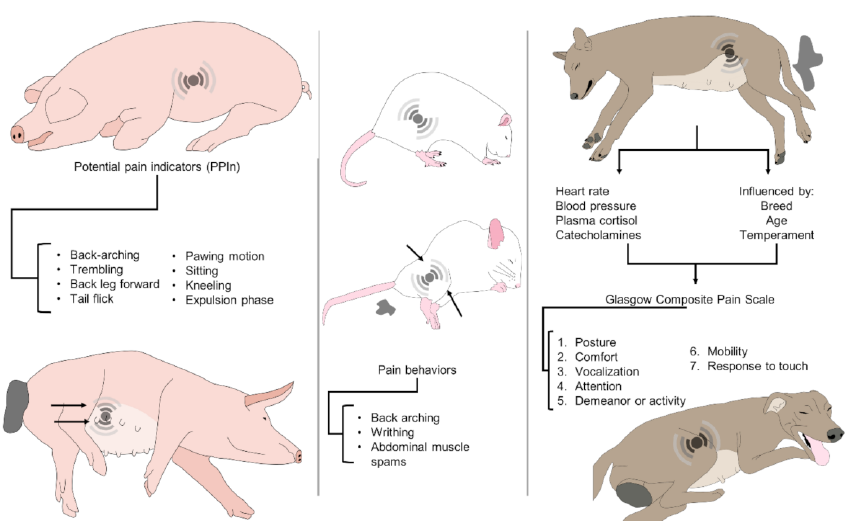
Figure 2. Clinical recognition of pain in sows, rats, and bitches. The recognition of pain during labor in these species can be done by observing altered postures or physiological parameters. In sows, potential pain indicators, such as a back-arching, one back leg forward, sitting, kneeling, trembling, among others, are modified behaviors during parturition. In rats, pain behaviors such as a compact posture, back-arching, writhing, and abdominal muscle contractions are pain signals. Lastly, the Glasgow Composite Scale (CMPS) in dogs uses 7 units in which posture, vocalizations, behavior, mobility, among others, are evaluated together with physiological parameters and plasma cortisol and catecholamine